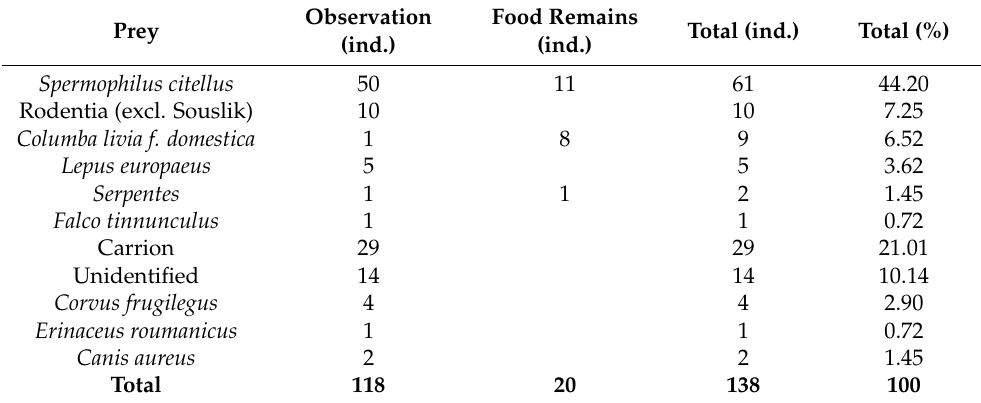
Table 2. Diet of non-territorial Eastern Imperial Eagle in dispersal